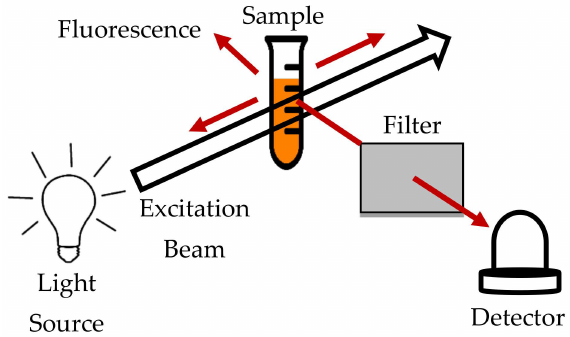
Figure 8. Fluorescence